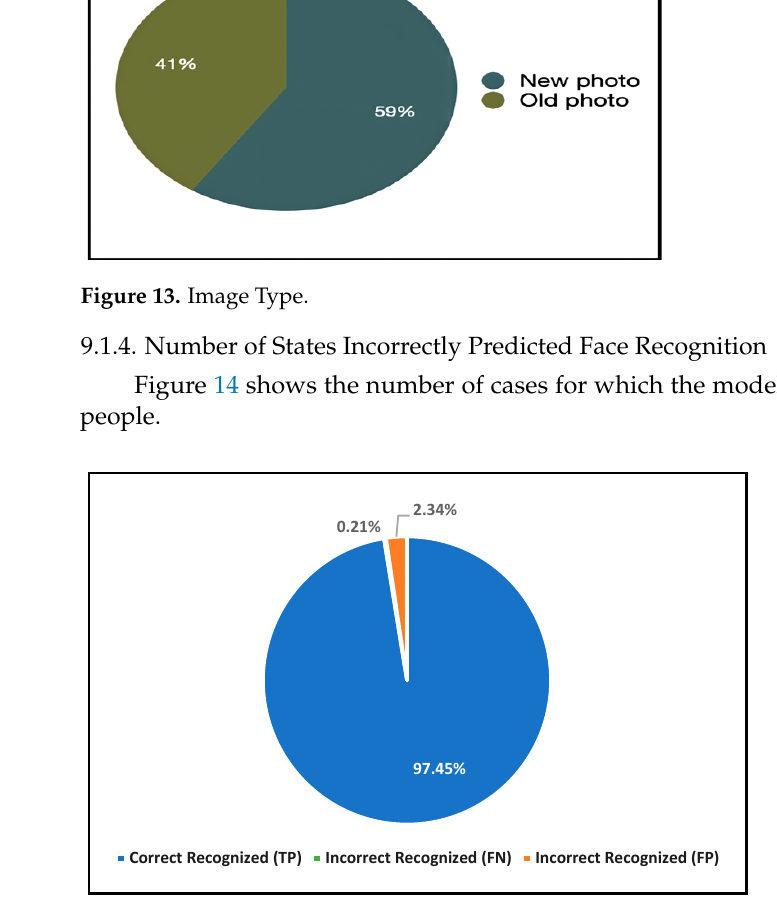
Figure 14. TP, FN and FP of face recognition in app.